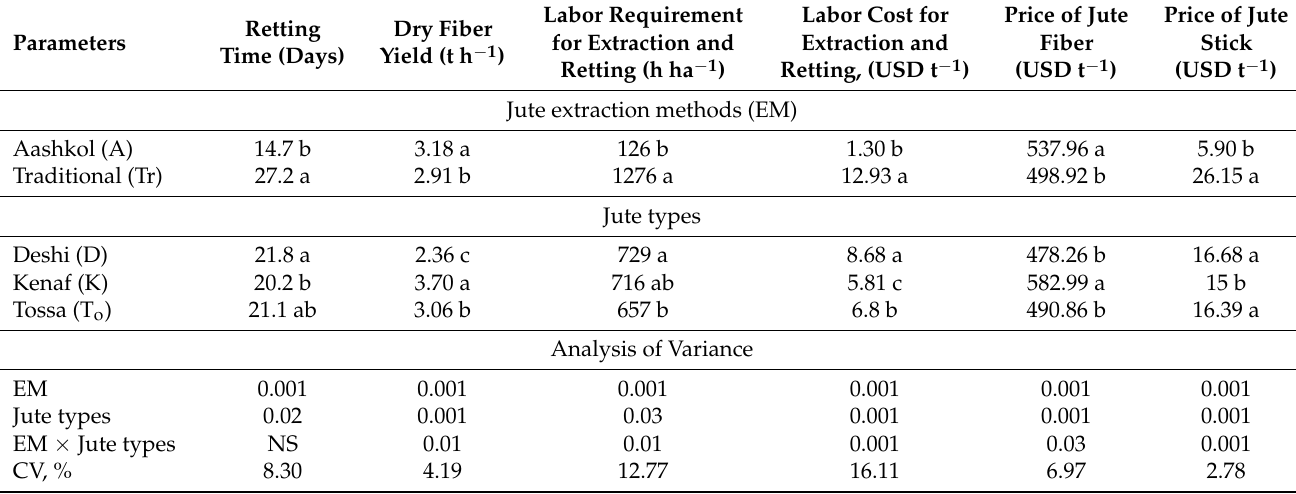
Table 4. Effect of jute extraction methods and jute types on jute fiber yield, retting time, labor requirement, and labor cost.